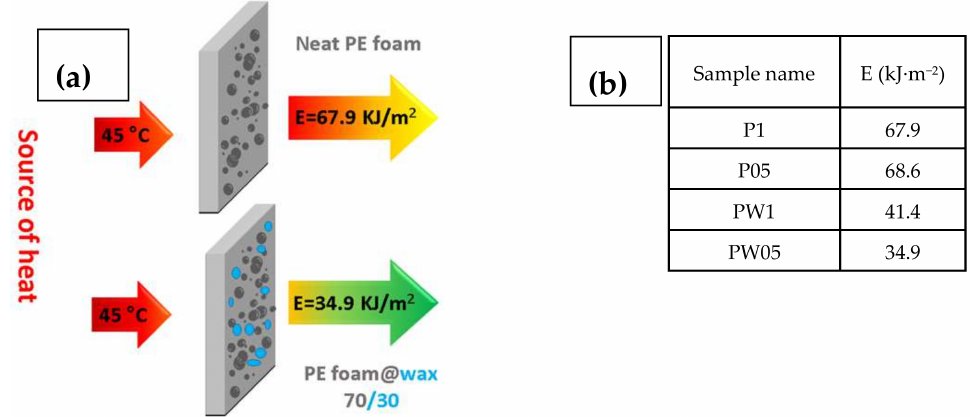
Figure 8. Schematic illustration describing the measurement principle ( a ) with calculated energies passed through the investigated samples ( b ).